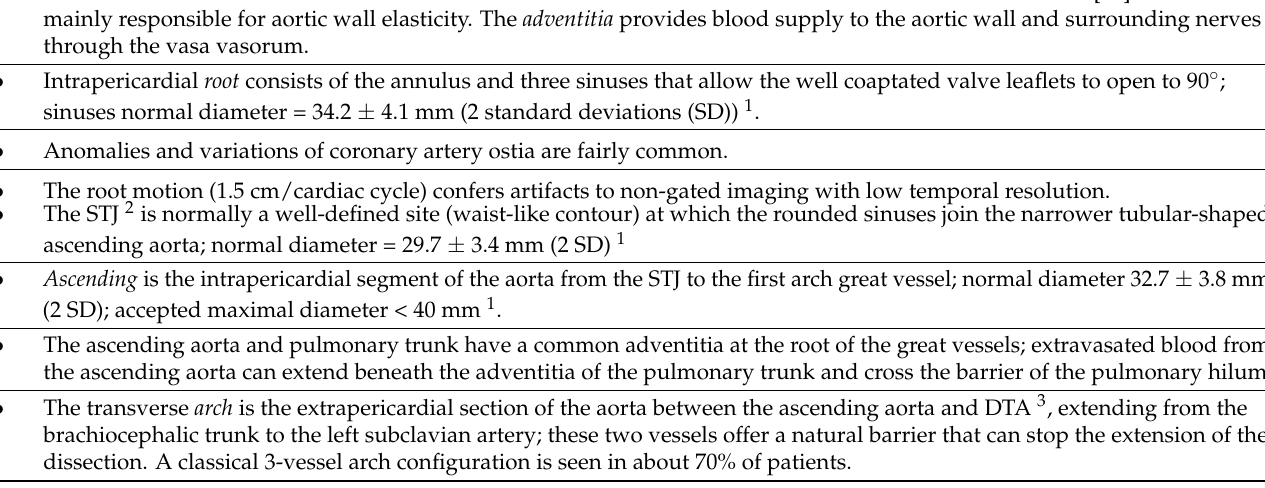
Table 2. Thoracic aorta anatomy: Imaging considerations and normal